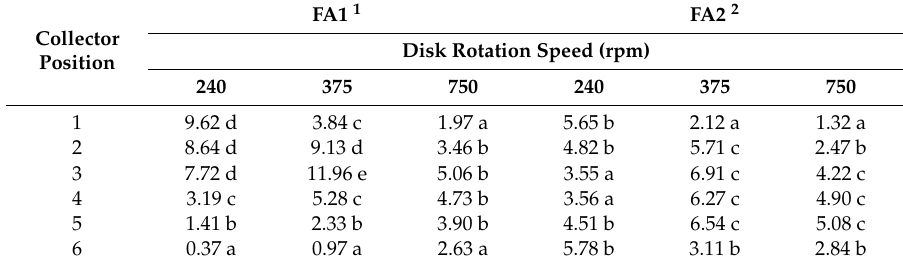
Table 2. The average fertilizer weight collected (g) at each collector position for di ff erent disk rotation